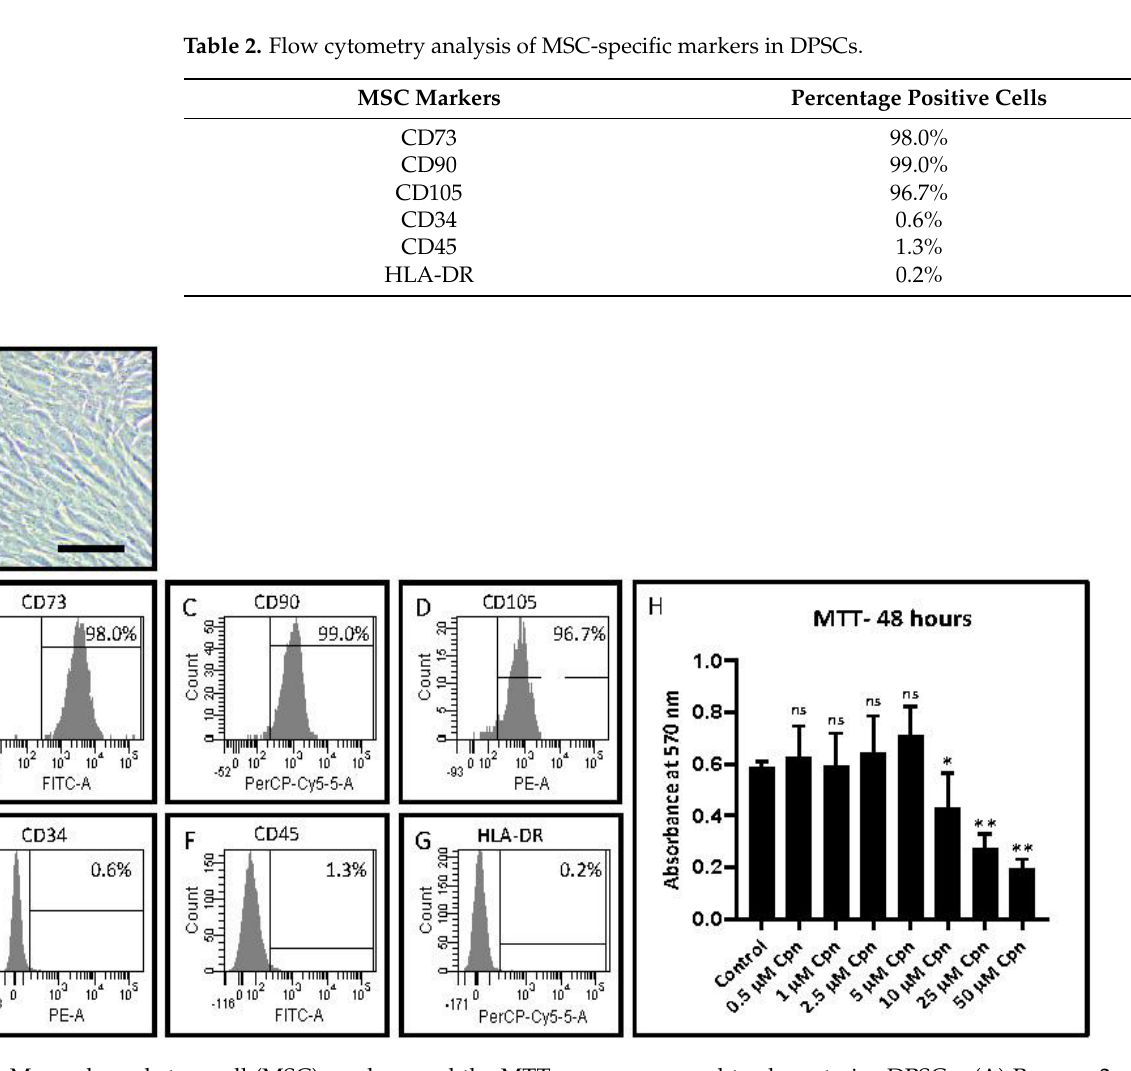
Figure 1. Mesenchymal stem cell (MSC) markers and the MTT assay were used to characterize DPSCs. ( A ) Passage 2 photomicrograph of DPSCs. Scale bar = 100 μm, ( B – G ) MSC-specific positive markers CD73, CD90, and CD105, as well as MSC-specific negative markers CD34, CD45, and HLA-DR, were examined in DPSCs. ( H ) For 48 h, DPSCs were treated with various concentrations of cordycepin (0.5 μM, 1 μM, 2.5 μM, 5 μM, 10 μM, 25 μM, and 50 μM) and a comparative